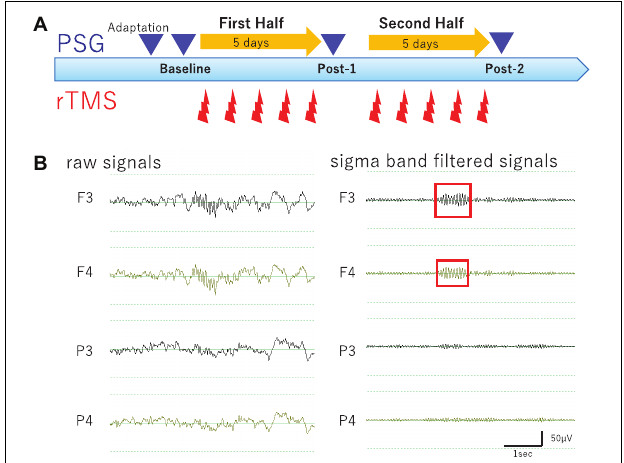
FIGURE 1 | Study Protocol and Raw EEG data. (A) Experimental protocol. Diagram illustrates the experimental protocol of the present study. To evaluate cumulative effects of diurnal rTMS sessions on the nocturnal sleep, PSG recordings were performed over four nights: Adaptation, Baseline, Post-1 (after the fifth rTMS session), and Post-2 (after the tenth rTMS session). In each rTMS session over left DLPFC, 1,000 pulses were delivered as 25 trains of 2 s at 20 Hz with an intertrain interval of 28 s. (B) Raw EEG data of all night polysomnography recordings. An example of raw EEG data was illustrated from four monopolar derivations of F3, F4, P3, and P4 during NREM Stage II sleep. Sigma band filtered signals were illustrated at the